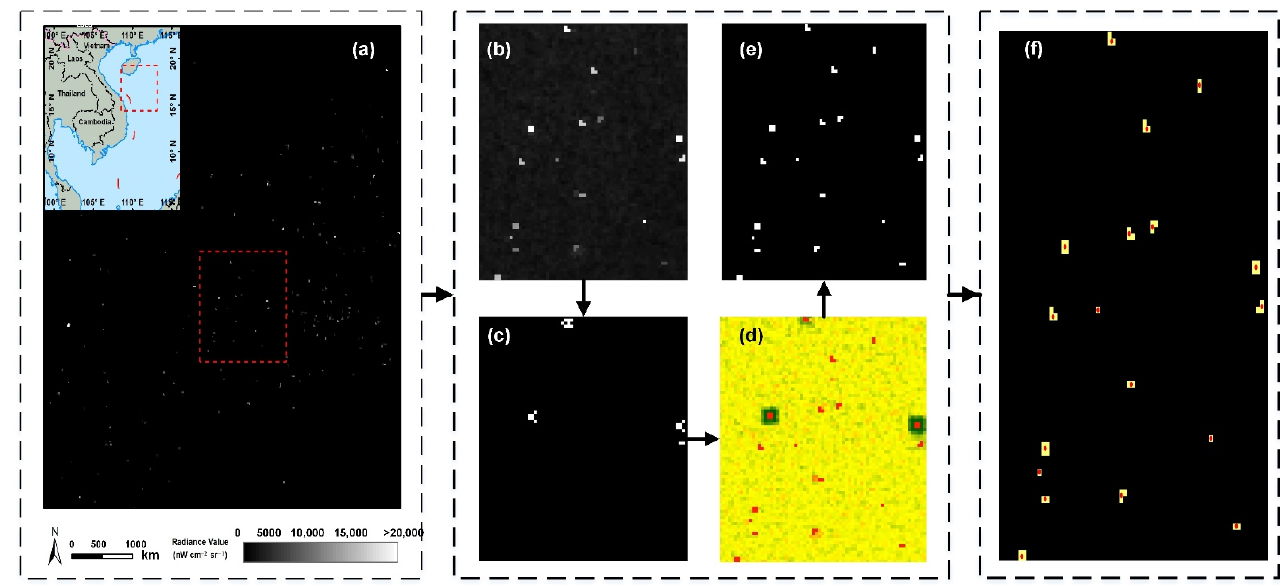
Figure 4. Workflow of detection algorithm ( a , b ) identified region in the VIIRS image at the global and zoomed-in scale ( c ) illumination edge detection result ( d ) candidate detection result ( e ) segmentation result ( f ) nighttime light results.